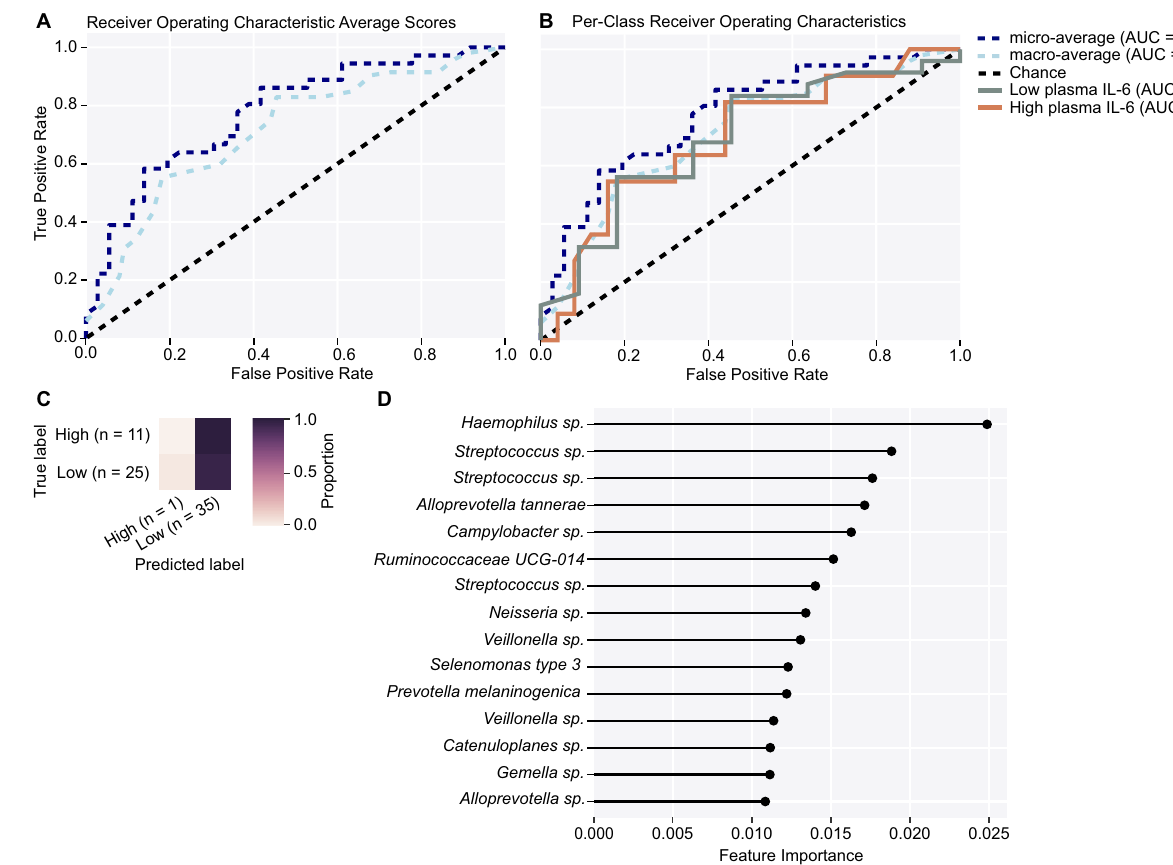
Figure 6. Machine learning classification accuracy in a nested cross-validation random forest model built to predict plasma IL-6 concentrations in mice from this study based on features of the cecal microbiome. Feature inputs from the raw feature table included in this analysis consisted of all bacteria matched to the Silva_132 ribosomal RNA gene reference database with 99% accuracy. (A) Receiver operating characteristic (ROC) plot shows macro-average precision (of each IL-6 classification equally-weighted, light blue dashed line, AUC = 0.71) at several true-positive rate (TPR) against false-positive rate (FPR) thresholds; micro-average precision (averaged metrics across each sample, dark blue dashed line, AUC = 0.77) at several TPR against FPR thresholds; and classification error rate achieved by random chance (black dashed line). (B) Per-class ROC shows the accuracy results for low (green) and high (orange) plasma IL-6 concentration classifications in this study. The overall accuracy in classifying low and high plasma IL-6 in mice was 69%. (C) The prediction matrix shows that a large proportion of samples were correctly classified in the low plasma IL-6 group. However, random forest classification performance was poor in utilizing features to identify samples in the high plasma IL-6 group; n = 10 samples were incorrectly classified in the low category for a total of n = 35. More accurate assessments of the True Label by the algorithm are correlated with darker shading. (D) Top 15 feature rankings in the random forest analysis. AUC area-under-the-curve, FPR false positive rate, ROC receiver operating characteristics, TPR true positive